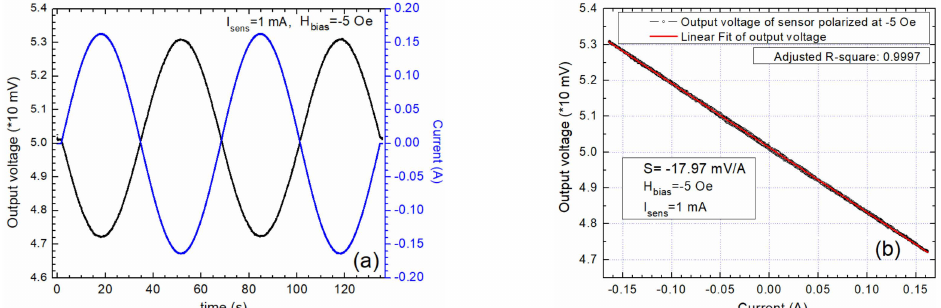
Figure 9. Output characteristics when the sensor AA003-02 is biased at − 5 Oe: ( a ) Comparison between the input current and the output voltage wave forms; ( b ) the output voltage as a function of the applied current through the current trace; the sensitivity is − 17.9 mV / A.